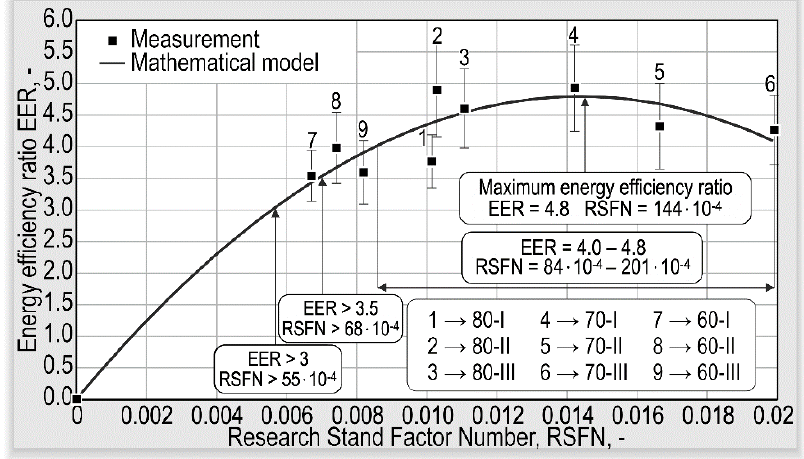
Figure 10. Distribution of measurement results and the values of the mathematical model of energy efficiency ratio as a function of the operation conditions of the prototype cold accumulator.